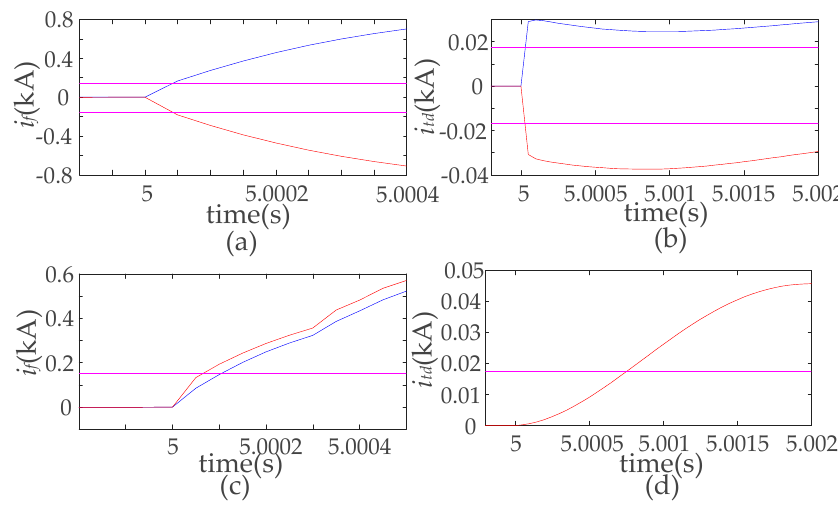
Figure 15. Transient current waveforms of s 2 and s 3 . ( a ) Pole-to-pole faults caused by f 1 ; ( b ) pole-to-ground faults caused by f 1 ; ( c ) pole-to-pole faults caused by f 2 ; ( d ) pole-to-ground faults caused by f 2 .